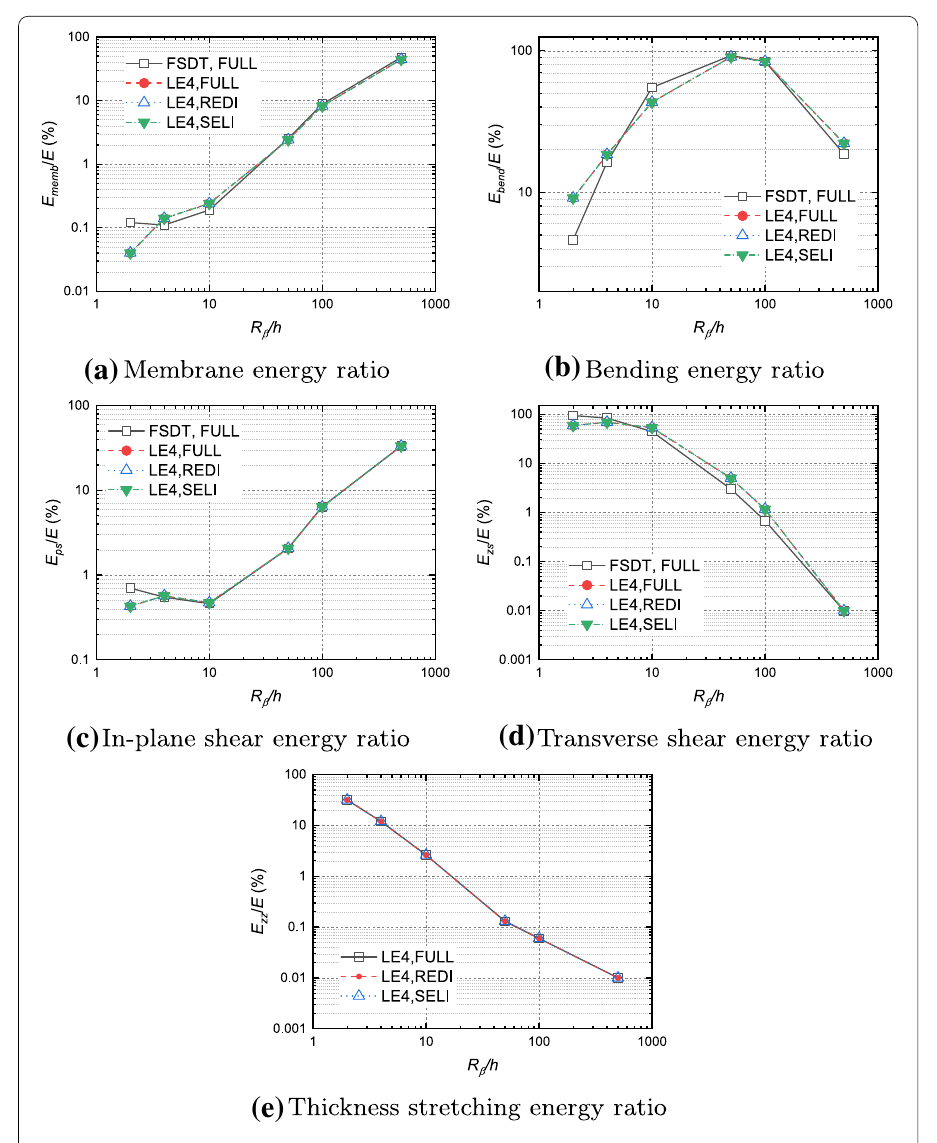
Fig. 11 Energy components versus radius-to-thickness ratio R β / h on the three-layered cylindrical shells under distributed